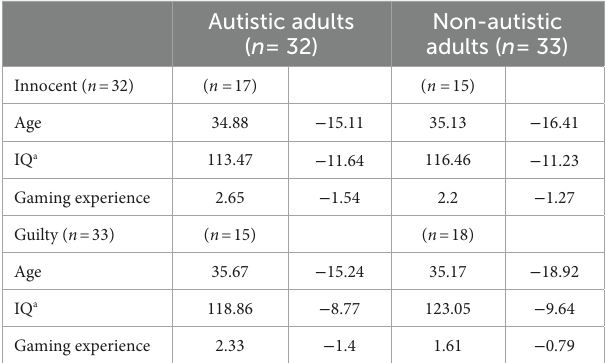
TABLE 1 Autistic and non-autistic group mean scores for age, IQ, and gaming experience within interview conditions (standard deviations in